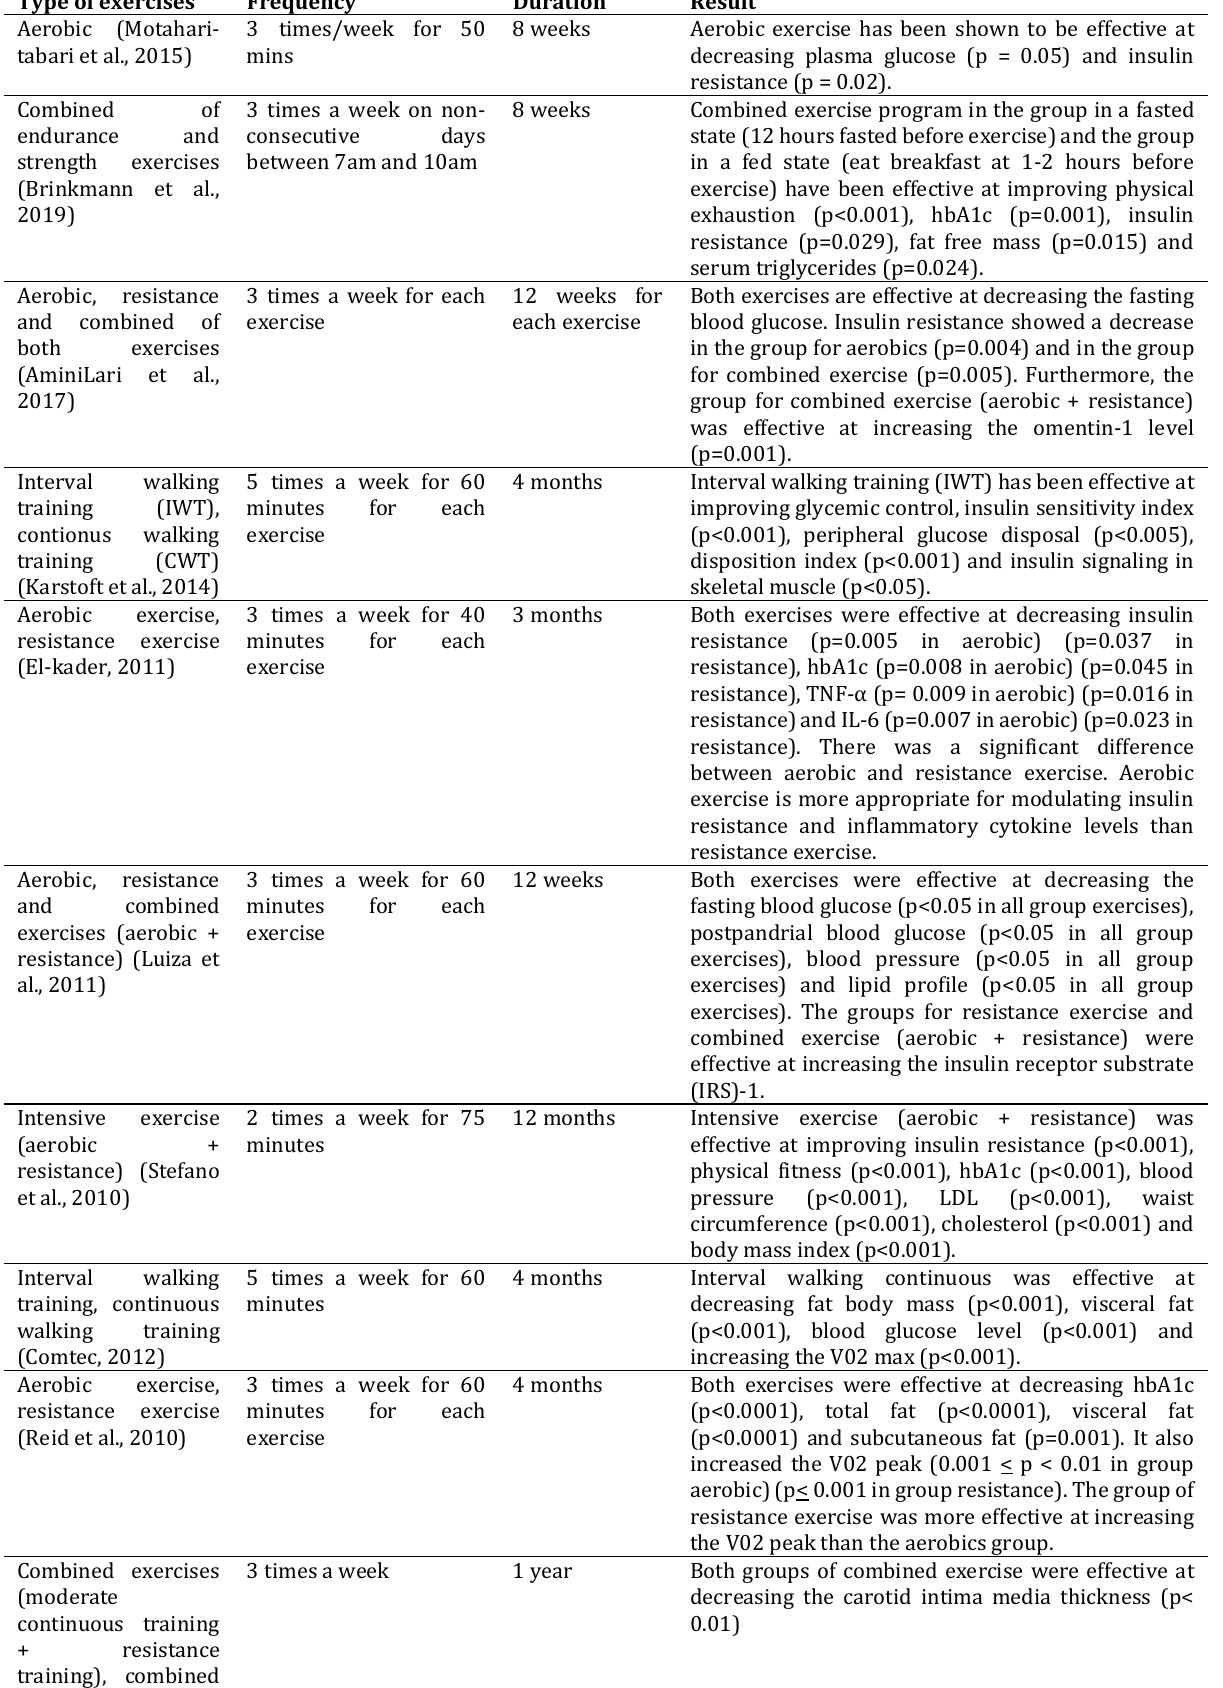
Table 2. Summary of the intervention programs and results Type of